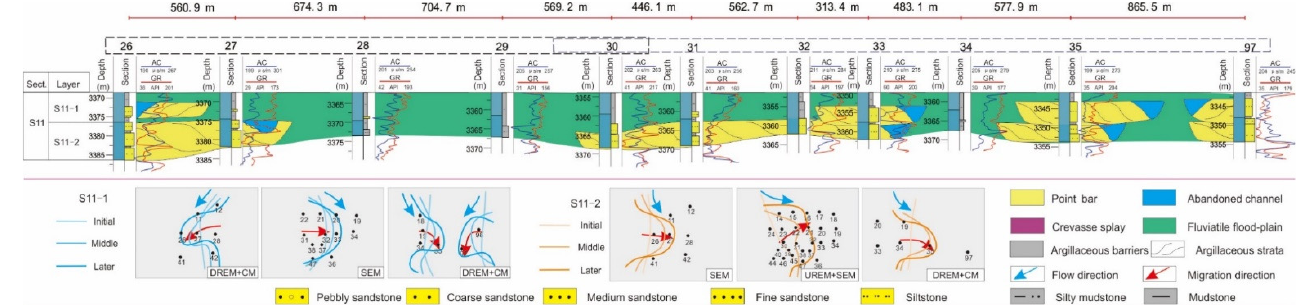
Figure 17. Profile T5 of comprehensive analysis including evolution model of meander bend-based multiple connected core wells which are collected from database in S 11 sublayer of Su-X block, Sulige gas field, Ordos Basin, China: migration areas Z2 (black frame), Z4 (gray frame).